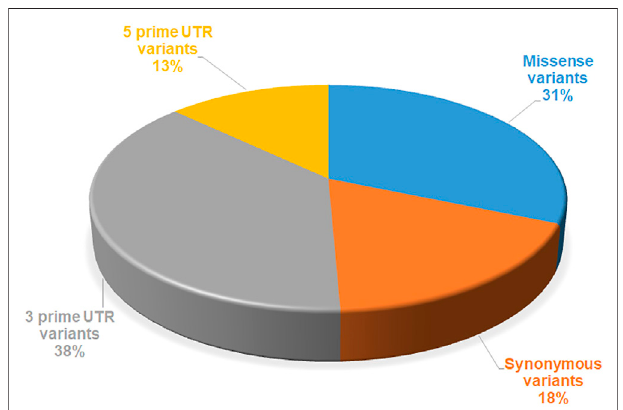
FIGURE 1 | Number of mutations reported in SGK1, extracted from the dbSNP